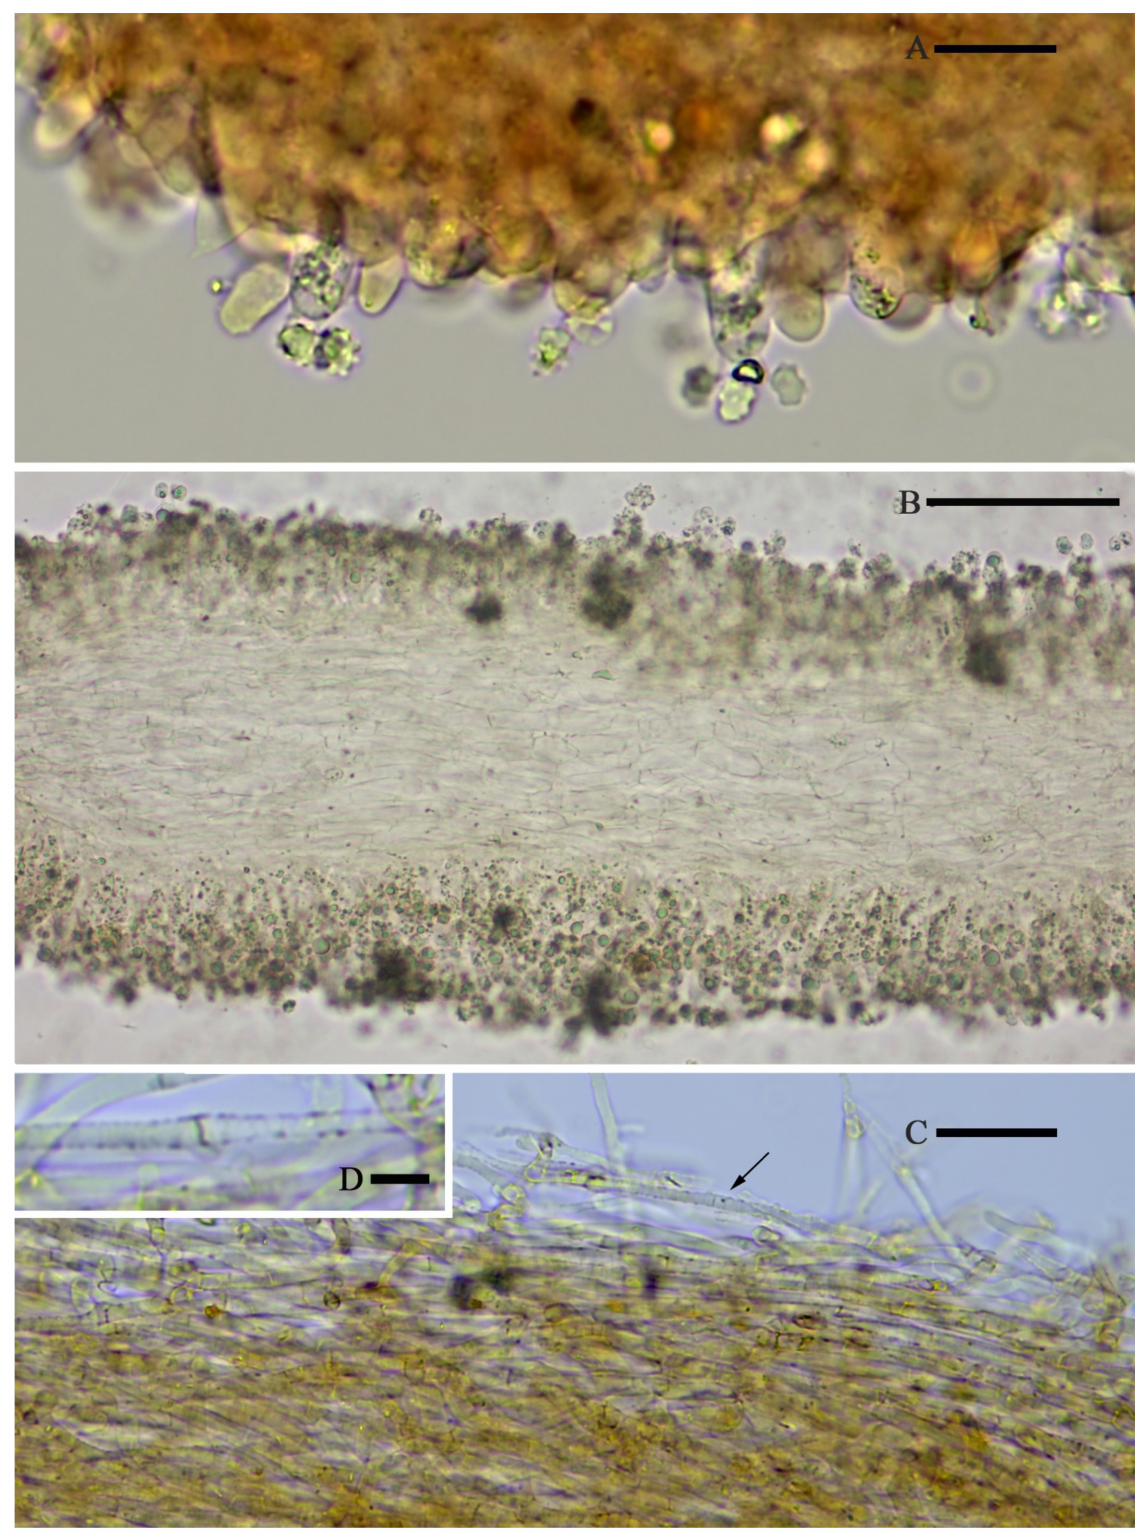
Figure 5. Microscopic features of Asproinocybe sinensis, from HMJAU59025 (Holotype), in pure water. ( A ) Margin of lamella, ( B ) Hymenophoral trama, ( C ) Pileipellis, and ( D ) Hypha with incrustation, from Pileipellis. Scale bar ( A ) = 20 µ m, ( B ) = 100 µ m, ( C ) = 20 µ m, and ( D ) = 5 µ m. Photos by Guang-fu